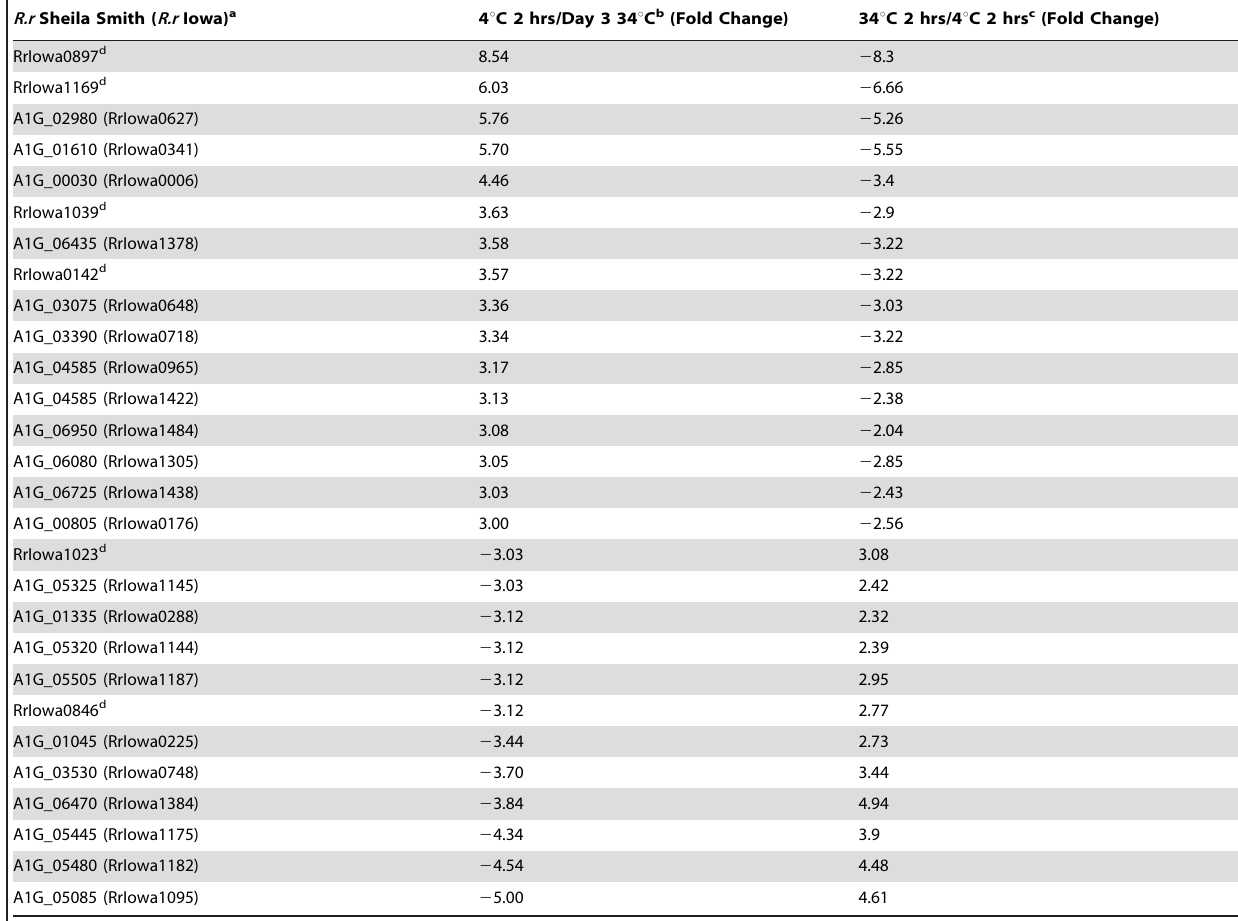
R.r Sheila Smith ( R.r Iowa)